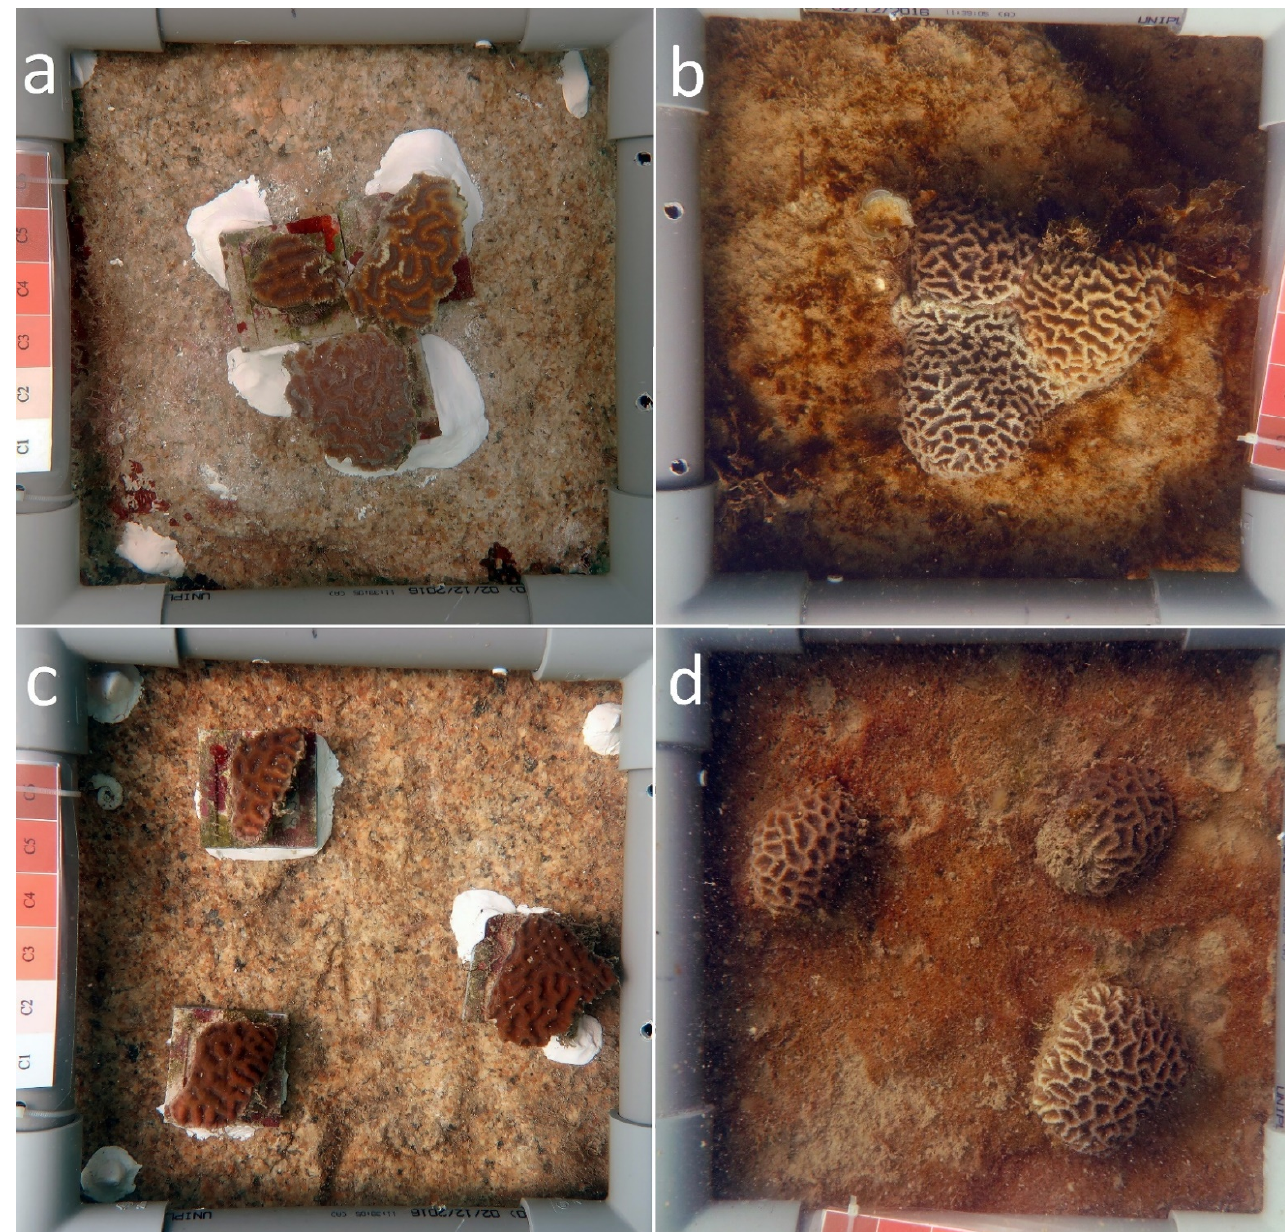
Figure 2. Representative fragments of Platygyra sinensis , transplanted approximately 0.5 cm apart at month 0 ( a ) and month 12 ( b ), transplanted approximately 5 cm apart at month 0 ( c ) and month 12 ( d ). Length of each coloured square = 2 cm.